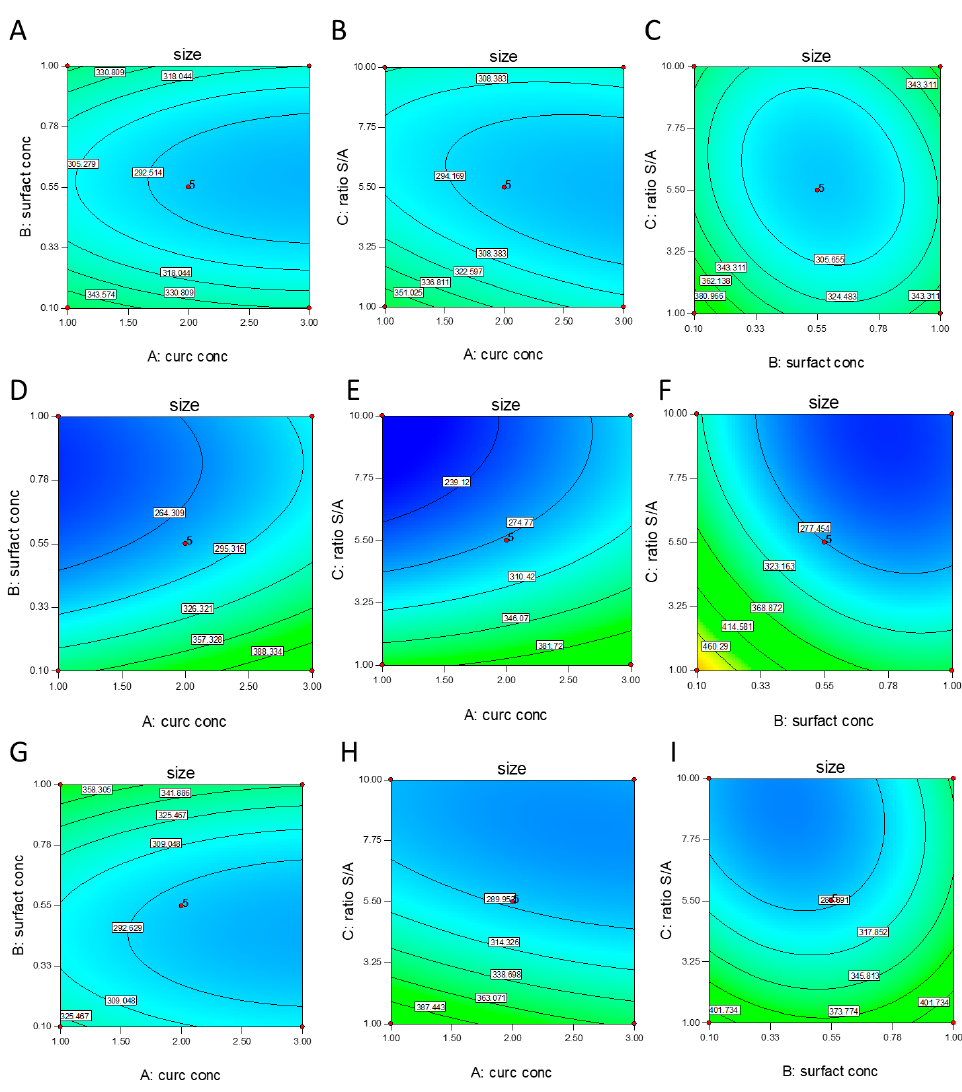
Figure 2. Contour plot of the effect of ( A ) X1 = A: curcumin concentration (mg/mL) versus X2 = B: surfactant concentration (% w/v), ( B ) X1 = A: curcumin concentration (mg/mL) versus X2 = C: S/A poloxamer 188. 3D surface of the e ff ect of ( D ) X1 = A: curcumin concentration (mg / mL) versus X2 = B: surfactant concentration (% w / v ), ( E ) X1 = A: curcumin concentration (mg / mL) versus X2 = C: S /